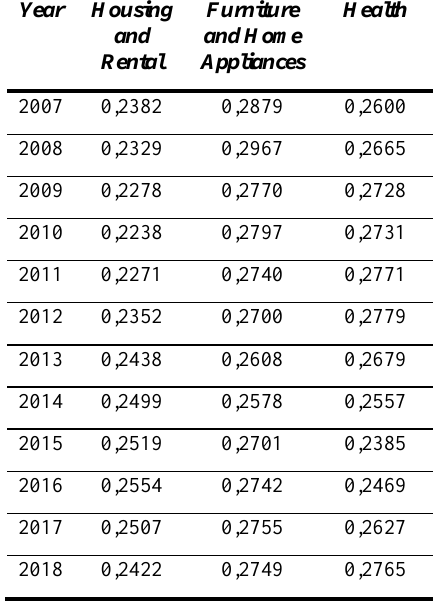
Table 2: Gini Coefficients of Housing and Rental, Furniture and Home Appliances, and Health